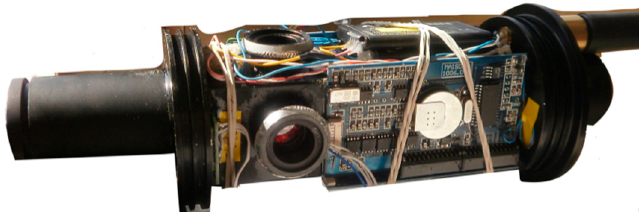
Figure 3. Electronic boards and components assembled around the measuring cell.